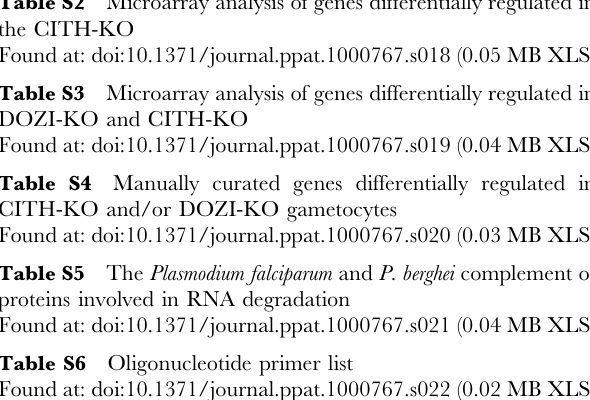
Table S7 Plasmodium berghei transgenic parasite lines Found at: doi:10.1371/journal.ppat.1000767.s023 (0.02 MB